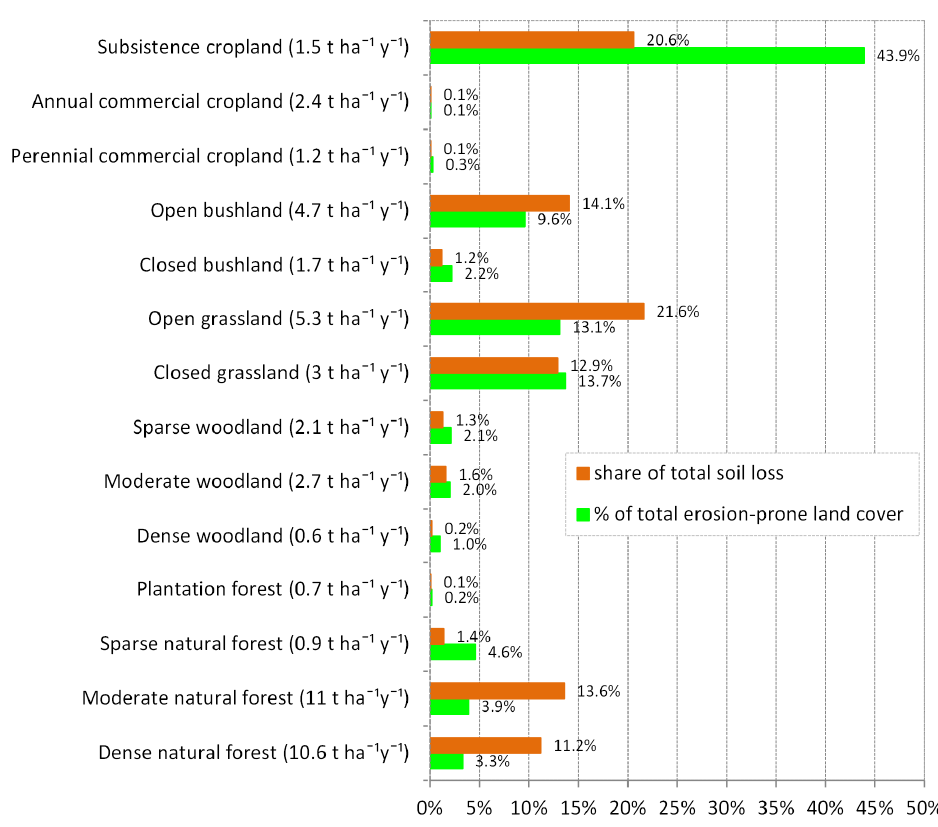
Figure 6. Rates of mean estimated soil loss per land cover and land use types and their corresponding shares of soil loss.